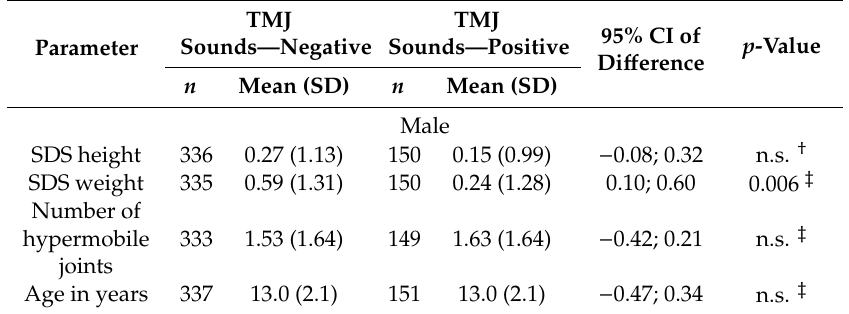
Table 2. Sex-dependent means and standard deviation (SD) of physical variables in relation to TMJ sounds; SDS: standard deviation scores, CI: confidence interval, n.s.: not significant.